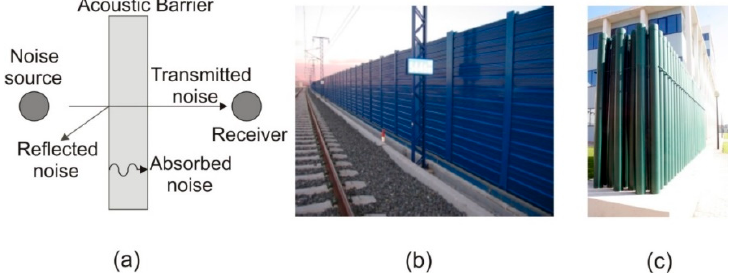
Figure 1. ( a ) Plan view of the acoustic performance of an Acoustic Barrier (AB); ( b ) Image of a classic acoustic barrier, made with a continuous surface, in the surroundings of a railway; ( c ) Picture of a SCAS made up with rigid cylinders as scatterers, where its transparency can be observed.